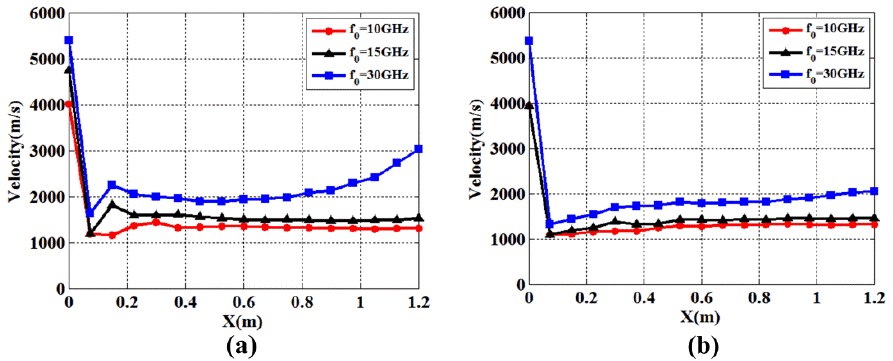
Figure 14. The velocities on the reflective surface of plasma sheath in scenes 4 and 5. ( a ) Velocity is Mach 20. ( b ) Velocity is Mach 25.